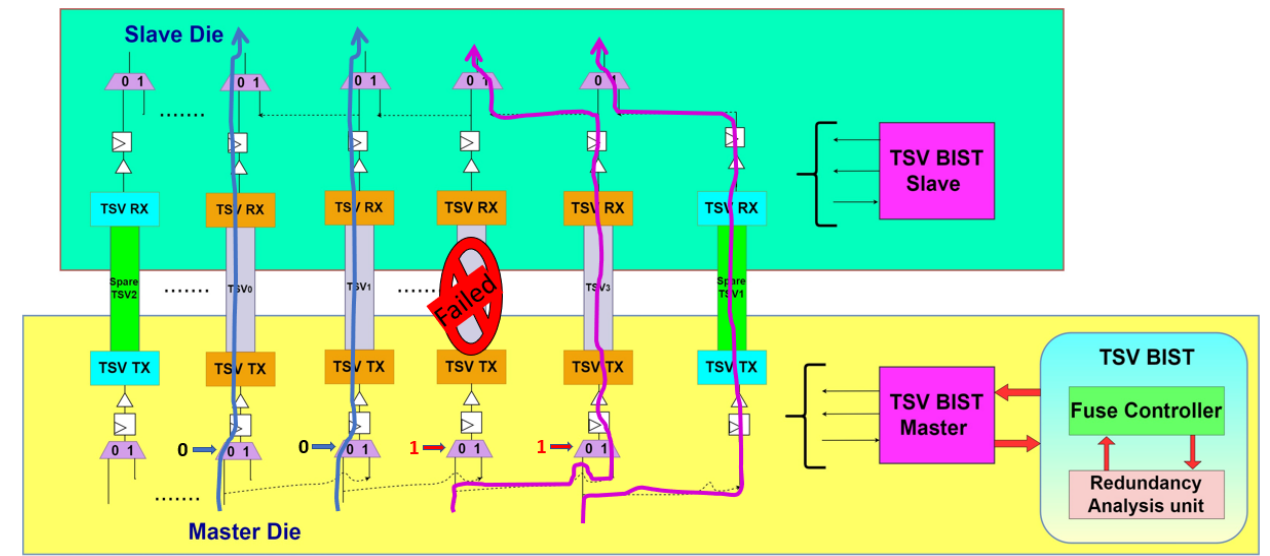
Figure 11. TSV BIST Repair flow in case fault in TSV group.